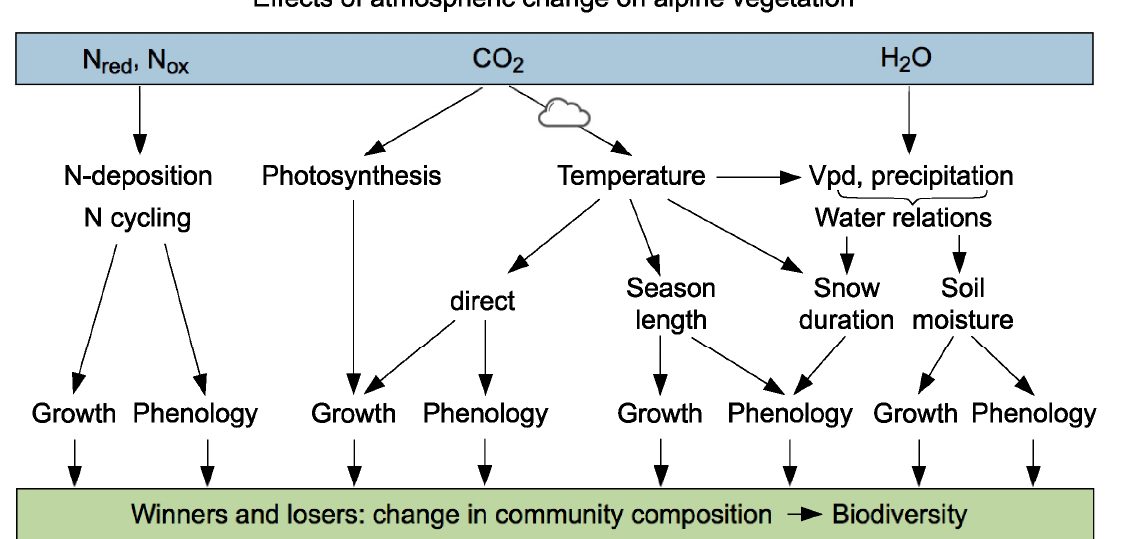
Figure 4. Examples of environmental drivers of high elevation plant life that may change to a variable degree with time and geographic regions. As a consequence of these changes, some species may profit (gain abundance or space), while other species may lose terrain, potentially causing competitive shifts in community composition and plant species diver- sity.